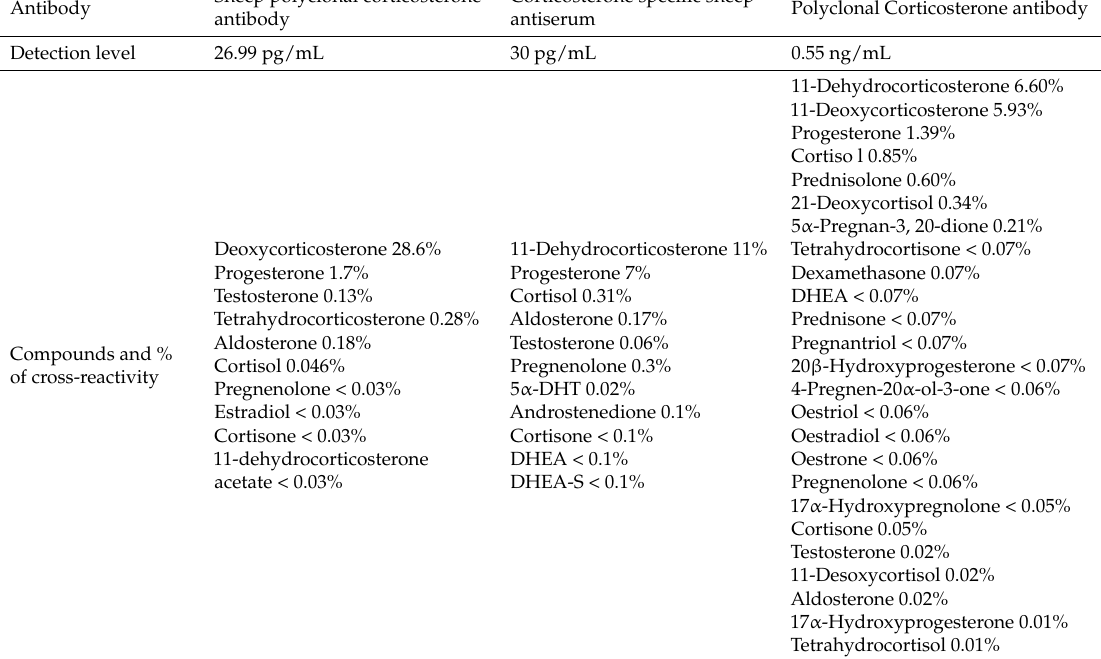
Table 1. Characteristics of commercial corticosterone enzyme immunoassay (EIA) kits tested in this study to assay glucocorticoid metabolites (GCM) in African Grey Parrots’ droppings. Kit Provider Enzo Life Sciences Cayman Chemical ImmunoDiagnostic Systems Sheep polyclonal corticosterone Corticosterone specific sheep Polyclonal Corticosterone antibody Antibody antibody antiserum Detection level 26.99 pg/mL